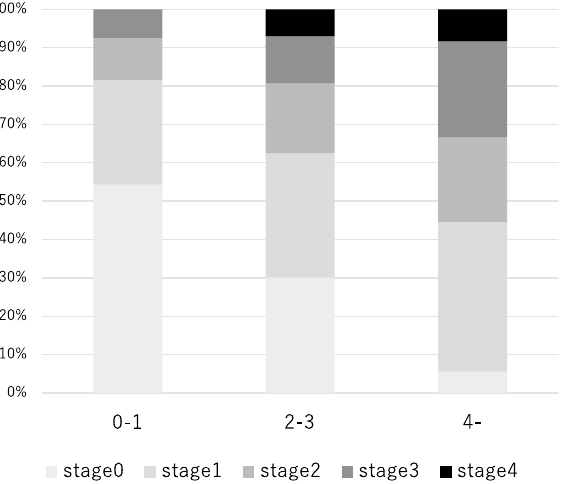
Figure 2. The prevalence of patients with each fibrosis stage according to the number of factors.